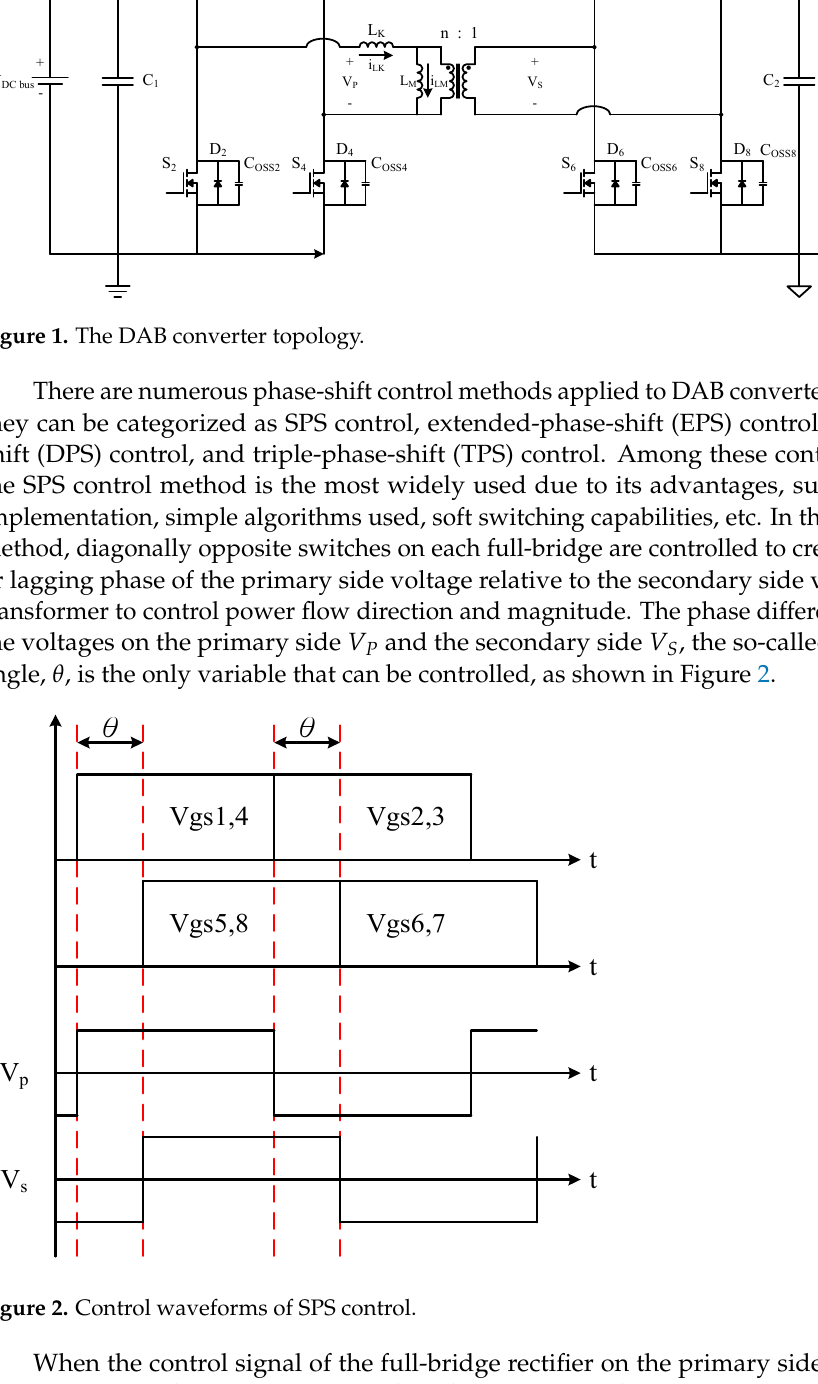
Figure 1. The DAB converter topology.